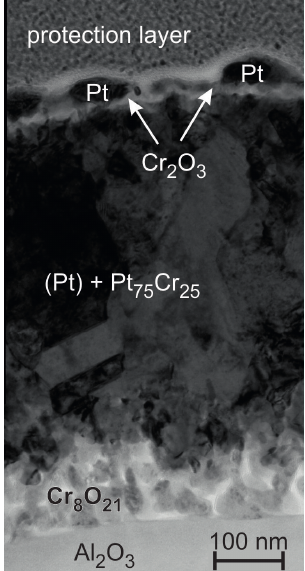
Figure 10. TEM image and EDX analysis of the Pt ∗ film on Cr seed layer after annealing at 600 ◦ C in air. The Cr-O phases are likely Cr 2 O 3 at the upper part of the film and Cr 8 Cr 21 at the interface to the